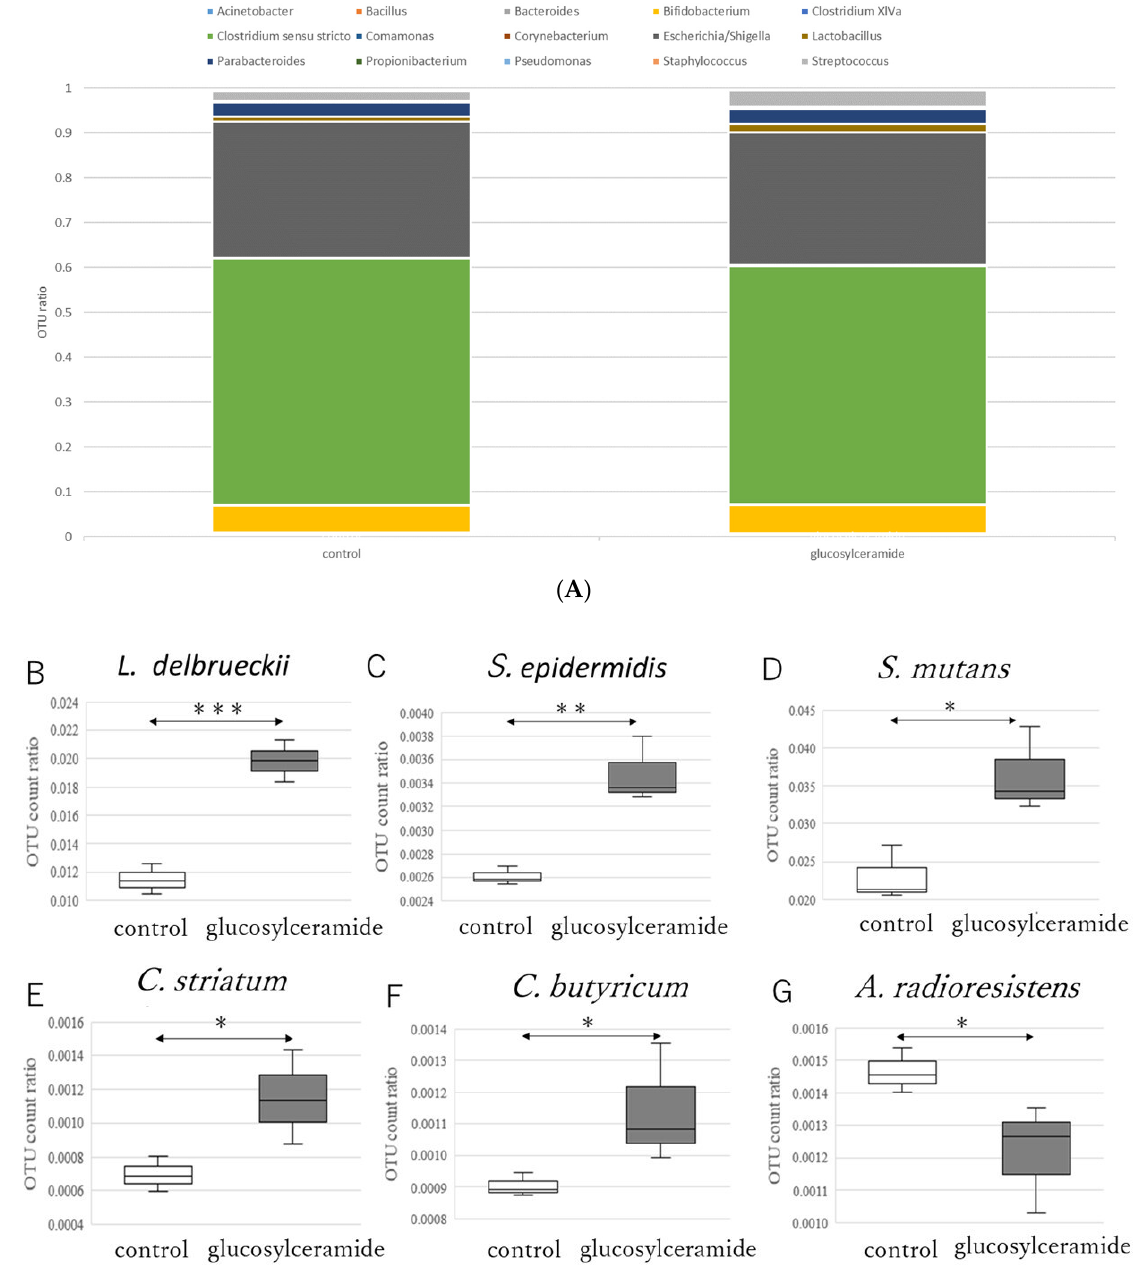
Figure 2. Relative OTU ratios of microbes treated with glucosylceramide. ( A ) Average relative OTU ratios of all microbes treated with glucosylceramide. Relative OTU ratios of ( B ) L. delbrueckii , ( C ) S. epidermidis , ( D ) S. mutans , ( E ) C. striatum , ( F ) C. butyricum and ( G ) A. radioresistens treated with glucosylceramide. Data are expressed as means ± standard errors. Data normality was verified using the Shapiro–Wilk test. Statistical differences in means of data with normalities were analyzed using a one-sided unpaired Student’s t -test ( n = 3; * p < 0.05, ** p < 0.01, *** p <